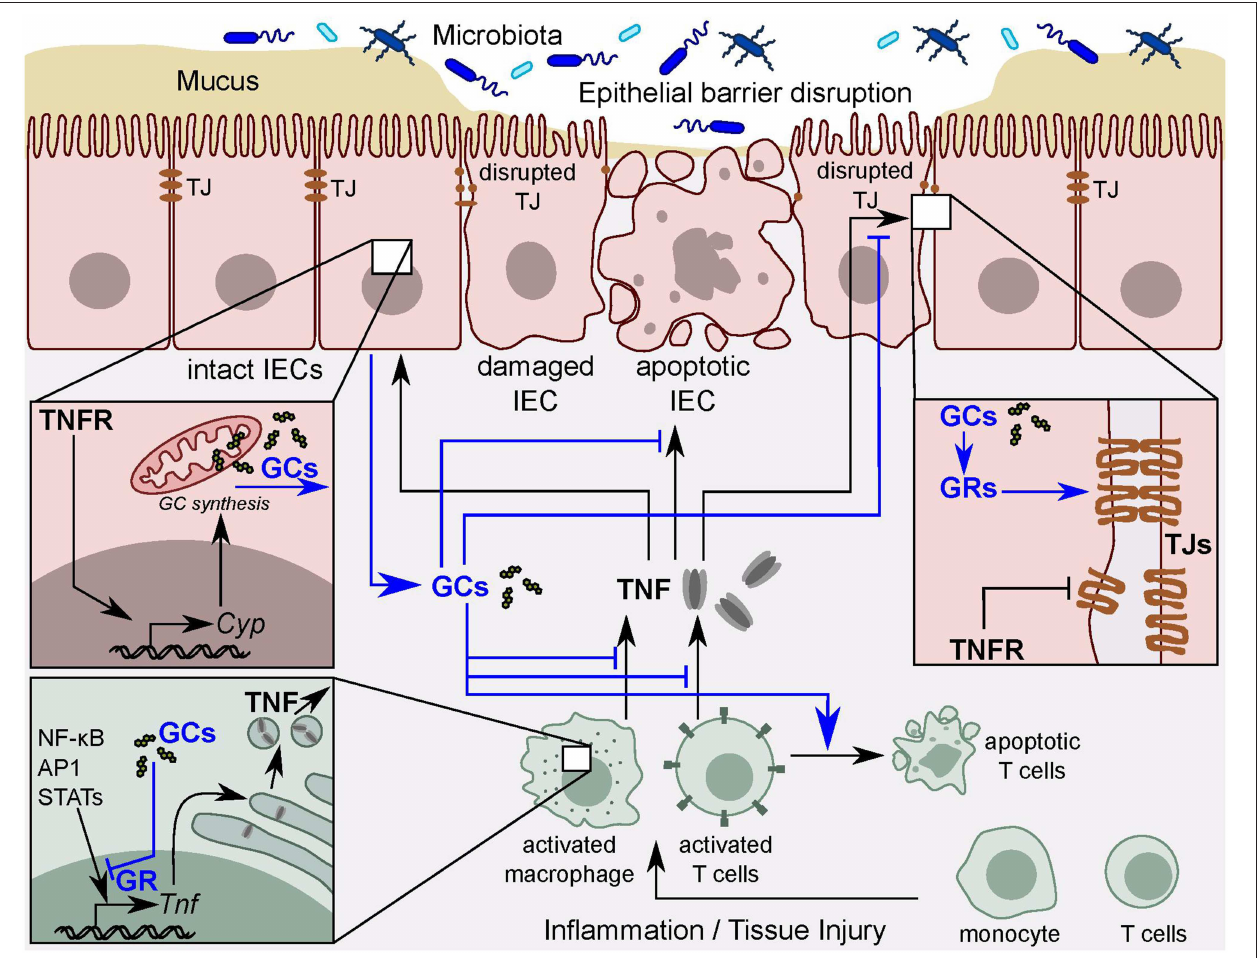
FIGURE 2 | TNF and intestinal GC synthesis. Intestinal epithelial barrier disruption leads to permeability defects and the subsequent interaction of intestinal immune cells with the luminal contents. Activated immune cells release pro-inflammatory cytokines, such as TNF. In turn, TNF results in tight junction (TJ) disruption and intestinal epithelial cell (IEC) apoptosis and thereby exacerbates local inflammation. TNF also directly stimulates IECs to synthesize and release immunoregulatory glucocorticoids (GCs) to counter-balance excessive tissue damage. GCs act via the glucocorticoid receptor (GR) to inhibit TNF-mediated tissue damage in a negative feedback loop. The GR also inhibits pro-inflammatory transcription factors, including NF- κ B, AP-1, and STATs leading to the resolution of the